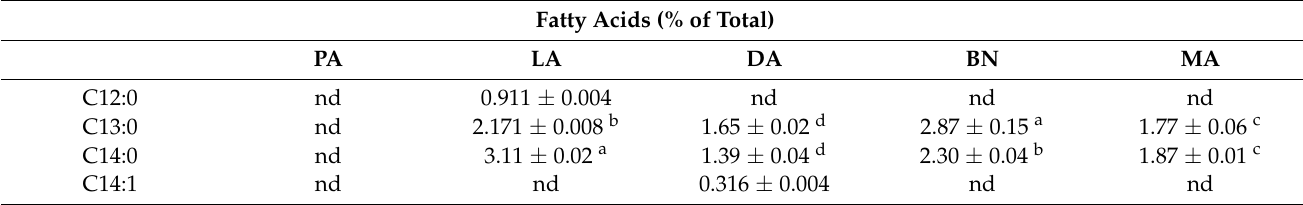
Table 5. CG-MS determination of lipidic fractions and fatty acid composition of fig leaves. Fatty Acids (% of